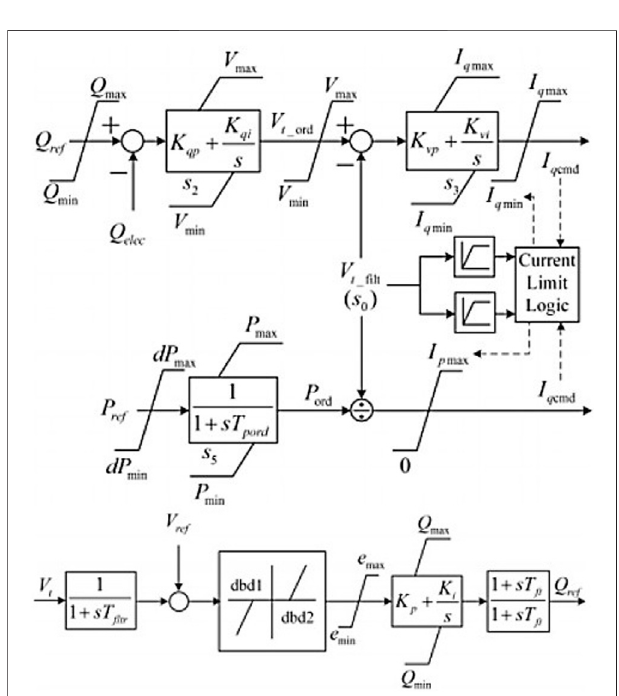
FIGURE 7 | The structure of model REECAU1 and